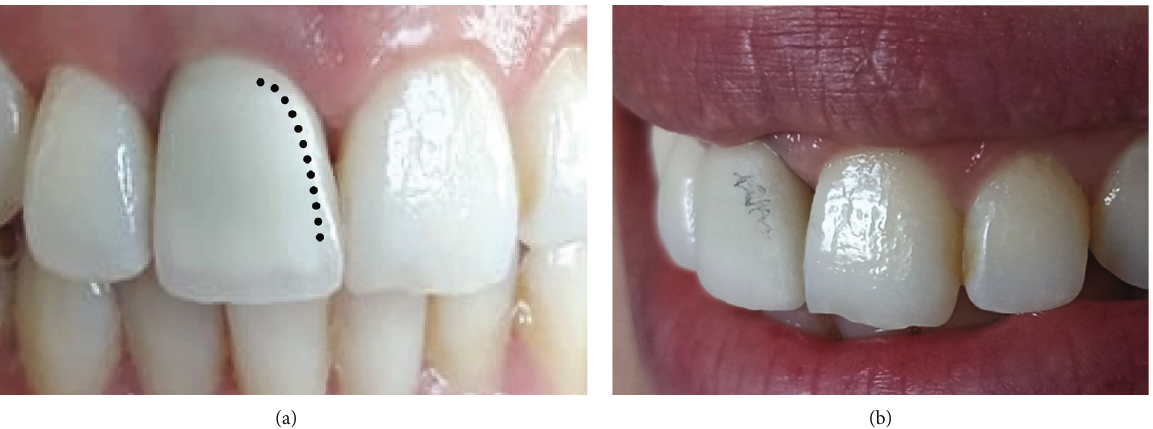
Figure 7: The intra oral checking of the crown after ceramic strati fi cation showing inappropriate mesial line angle (a) from the frontal view and (b) from the lateral view.